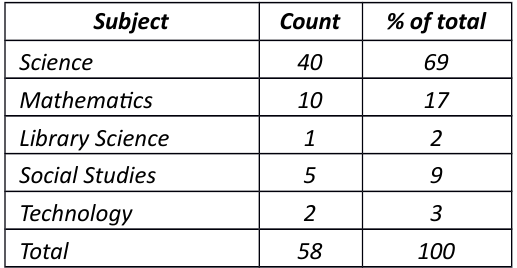
Table 4. Content areas of the ICCARS partcipatng